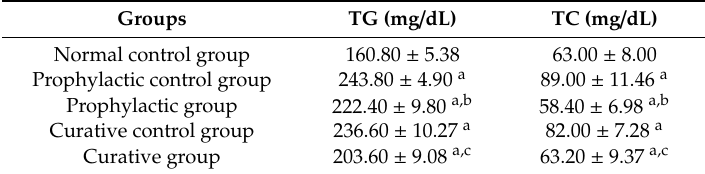
Table 3. E ff ect of Berberis vulgaris root extract ( Bv RE) on cisplatin-induced hyperlipidemia. Serum triglycerides (TG) and total cholesterol (TC) were measured in mg / dL.